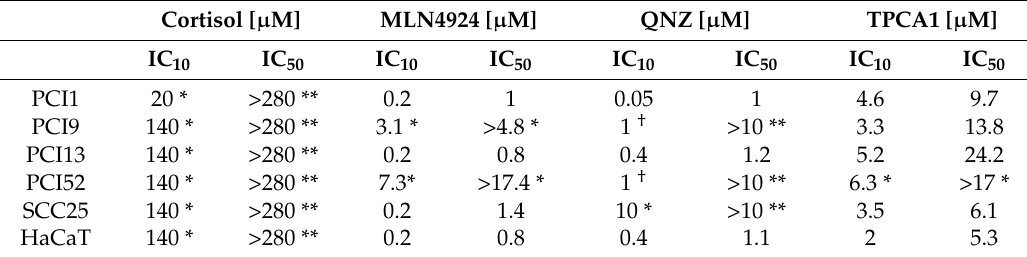
Table 1. Cell line-specific IC 10 and IC 50 values for the NF κ B inhibitors Cortisol, MLN4924, QNZ and TPCA1. Cells (1 × 10 4 /well) were stimulated for 72 h with the indicated concentrations of Cortisol, MLN4924, QNZ and TPCA1. The RCN was determined via crystal violet staining and normalised to that of the untreated control (100%). The IC 10 and IC 50 values were determined as described in the material and methods section. Three independent experiments were carried out to determine mean values ( n = 3). Cell lines for which no IC 10 or IC 50 values could be determined are marked with *. IC 50 values of inhibitors showing no effect or only a minimal effect are marked with **. In these cases, the maximum concentration is indicated. In PCI9 and PCI52, no IC 10 could be determined for QNZ. For cell lines marked with † , 1 µ M was defined as the IC 10 value.